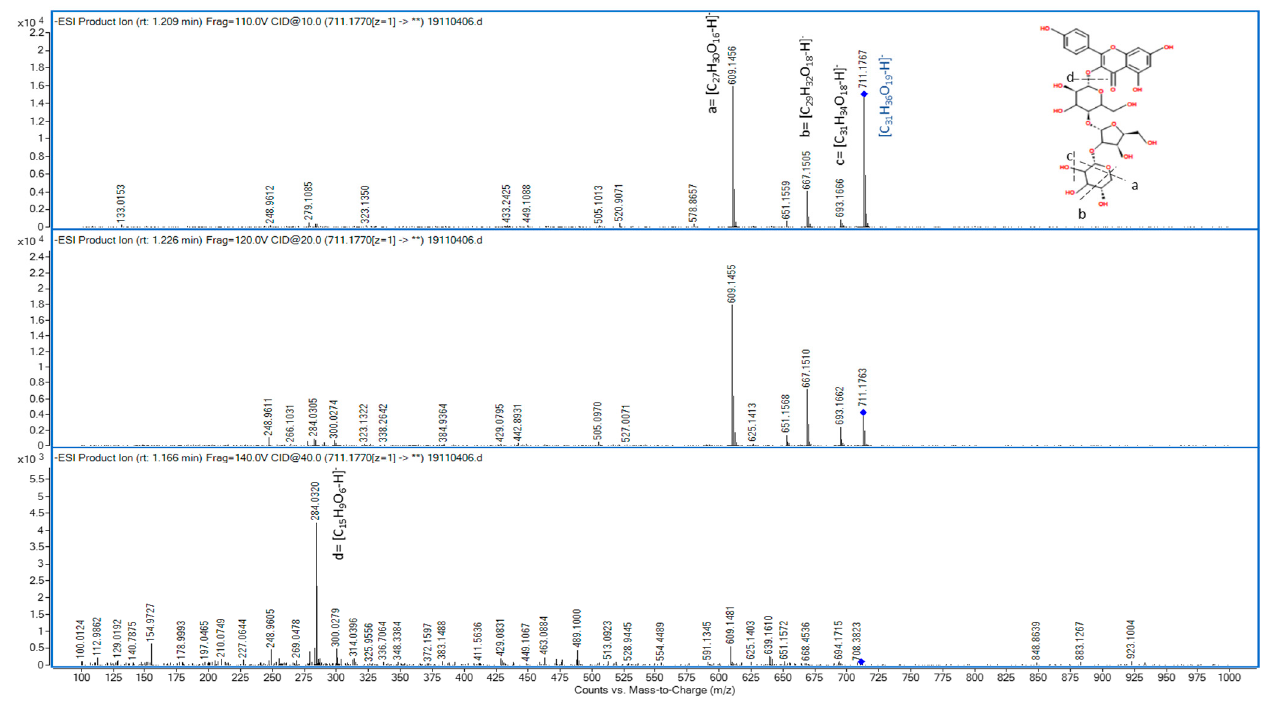
Figure 2. High resolution mass spectrum of primflasine (711 m / z ).